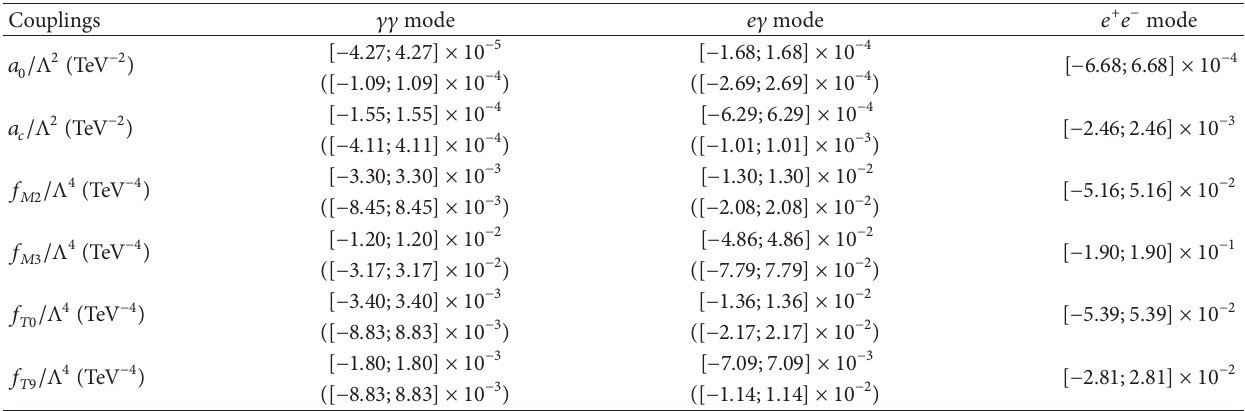
Table 2: 95% CL sensitivity bounds of 𝑎 0 /Λ 2 , 𝑎 𝑐 /Λ 2 , 𝑓 𝑀2 /Λ 4 , 𝑓 𝑀3 /Λ 4 , 𝑓 𝑇0 /Λ 4 , and 𝑓 𝑇9 /Λ 4 couplings for 2000 fb −1 integrated luminosity and √𝑠 = 3 TeV through the processes 𝛾𝛾 → 𝑍𝑍 , 𝑒 − 𝛾 → 𝑒 − 𝛾 ∗ 𝛾 → 𝑒 − 𝑍𝑍 , and 𝑒 + 𝑒 − → 𝑒 + 𝛾 ∗ 𝛾 ∗ 𝑒 − → 𝑒 + 𝑍𝑍𝑒 − . The values in the parentheses are calculated limits using the luminosity reduction factor.